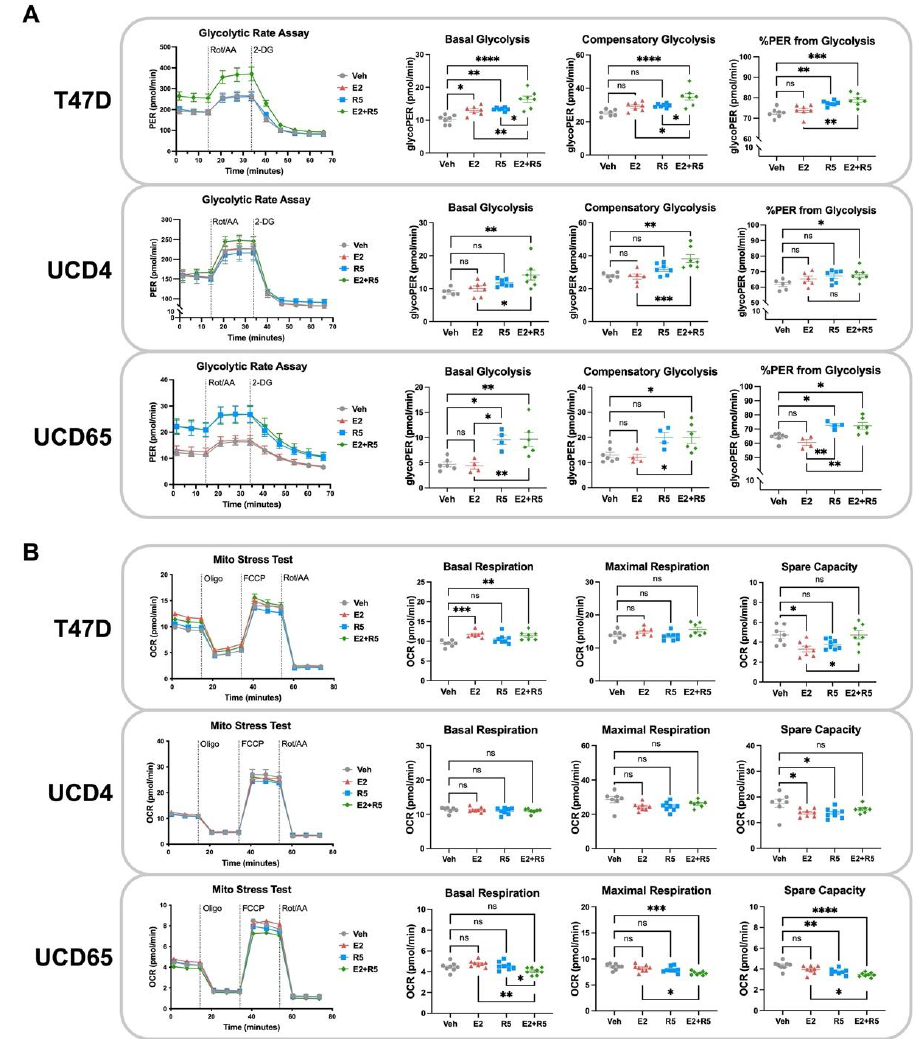
Figure 4. Estrogen plus progestin treatment increases glycolytic activity by Seahorse assay. Glycolytic rate ( A ) and Mito Stress Test ( B ) assays were conducted on T47D, UCD4, and UCD65 cells treated with estradiol (E2, 10 − 8 M), promegestone (R5, 10 − 8 M), combination (E2 + R5, 10 − 8 M each), or ethanol (Veh) for 24 h to assess glycolytic and mitochondrial oxidative activity, respectively ( n = 5–7 per treatment condition). ns = not significant, * p < 0.05, ** p < 0.01, *** p < 0.001, **** p < 0.0001 for the indicated comparisons using one-way